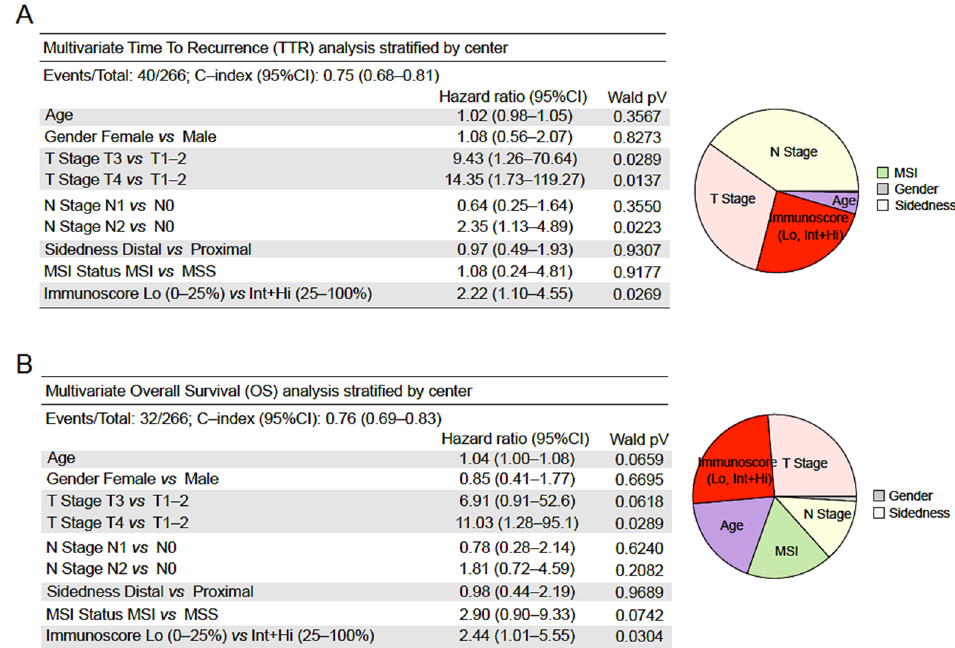
Figure 6. Clinical performance of tumor- and immune-related risk parameters. Cox multivariable regression analysis of TTR ( A ) and OS ( B ) combining clinical parameters and Immunoscore with two (0–25% and 25–100%) categories. Clinical parameters: age, gender, T-stage, N-stage, sidedness, and MSI status. The relative importance of each risk parameter to survival risk using the χ 2 proportion test for clinical parameters and Immunoscore (right).